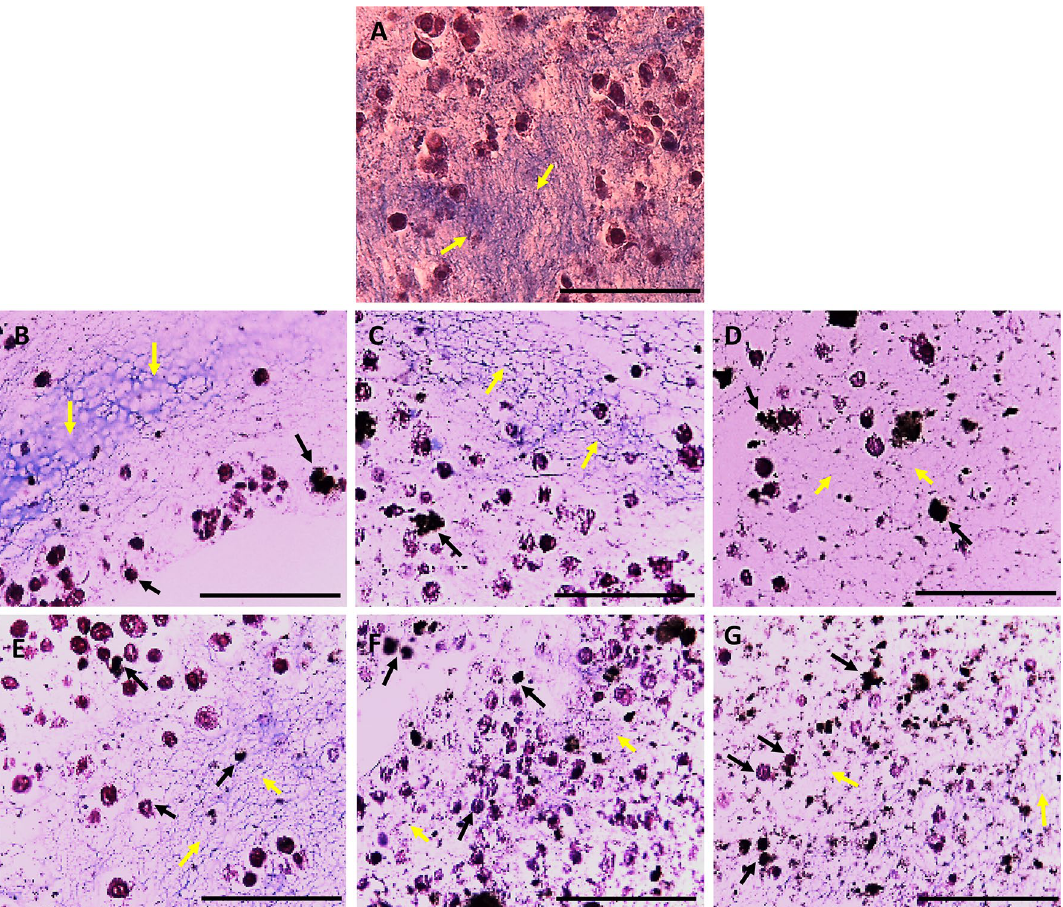
Figure 11. Microscopic images of collagen-based ECTs containing different concentrations of MWCNTs- Py-OH or MWCNT-Py-COOH. The tissue sections were stained with Masson’s trichrome stain and examined with a light compound microscope. ( A ) Control ECT; ( B ) 0.025% MWCNTs-Py-OH; ( C ) 0.050% MWCNTs- Py-OH; ( D ) 0.100% MWCNTs-Py-OH; ( E ) 0.025% MWCNTs-Py-COOH; ( F ) 0.050% MWCNTs-Py-COOH;